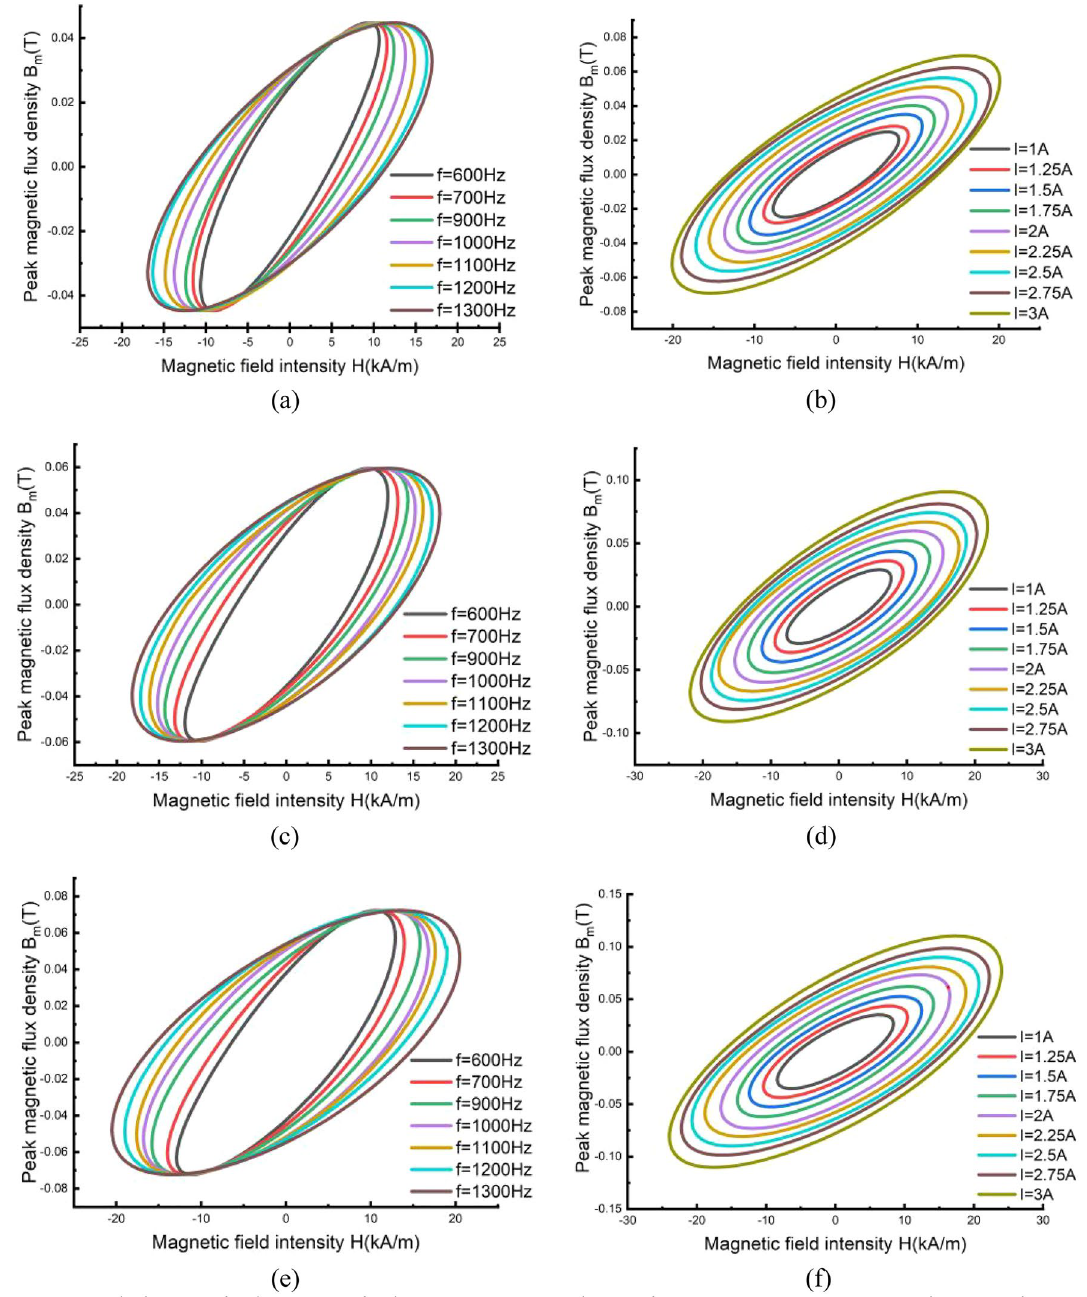
Figure 9. Measured dynamic hysteresis loops: ( a ) Section 1/5: B m = 0.044735 T, ( b ) Section 1/5: f m = 1000 Hz; ( c ) Section 2/4: B m = 0.05955 T, ( d ) Section 2/4: f m = 1000 Hz, ( e ) Section 3: B m = 0.07228 T, (f) Section 3: f m = 1000